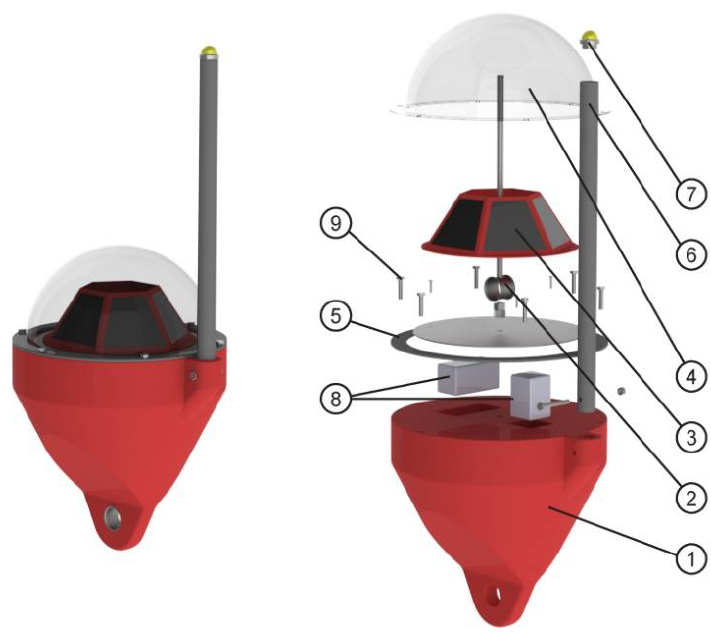
Figure 8. Exploded view of the oceanographic buoy, composed of ( 1 ) floating assembly, ( 2 ) galvanized steel insert system, ( 3 ) solar panel support, ( 4 ) transparent dome, ( 5 ) rubber seal, ( 6 ) mast, ( 7 ) beacon, ( 8 ) electronic equipment, and ( 9 ) set of screws and nuts.